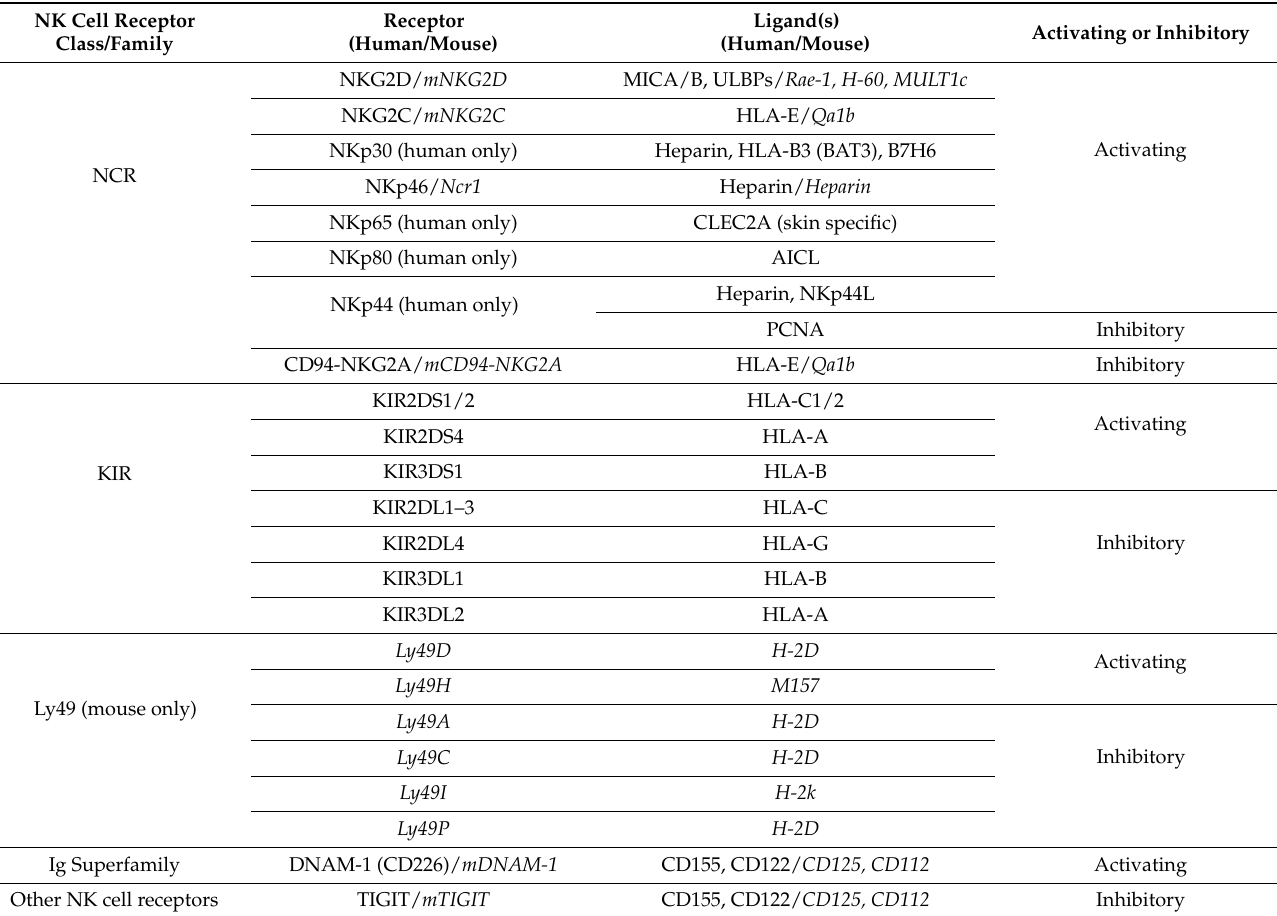
Table 1. Known activating and inhibitory receptors and ligands in NK cells in mice and humans [9–11,13,14,23,25–32]. KIRs have a particular nomenclature: the first number following KIR indicates the number of immunoglobulin (Ig)-domains on the extracellular portion of the receptor, the second number indicates the length of the cytoplasmic tail and its activation state [19]. For example, KIR2DL4 has two Ig-domains (2D) and the length of its cytoplasmic tail represented by L or S where, they are either inhibitory or activating, respectively. TIGIT and DNAM-1 are other NK cell receptors that are also present on other immune cells, like